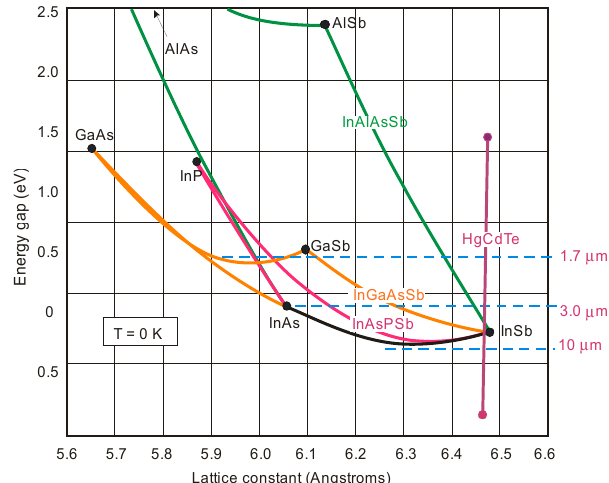
Figure 6. Composition and wavelength diagram of semiconductor material systems.